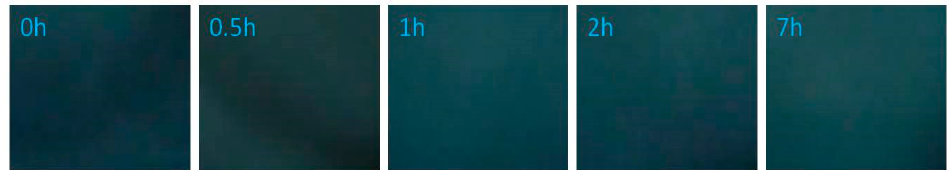
Figure 3. Variation of the color solution for System 0, as a function of the UV irradiation time exposure.